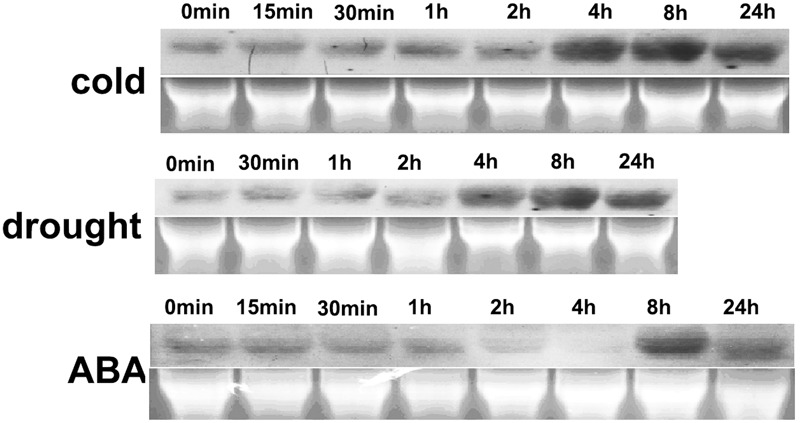
Changes in HbEBP1 expression in response to cold and drought stress and ABA treatment. Total RNA from the leaves of rubber tree seedlings treated with cold, drought or ABA for the indicated time was used for northern blotting With probes prepared from full-length HbEBP1 cDNA. Ethidium bromide–stained rRNA was used as an internal standard to monitor equal loading of total RNA.